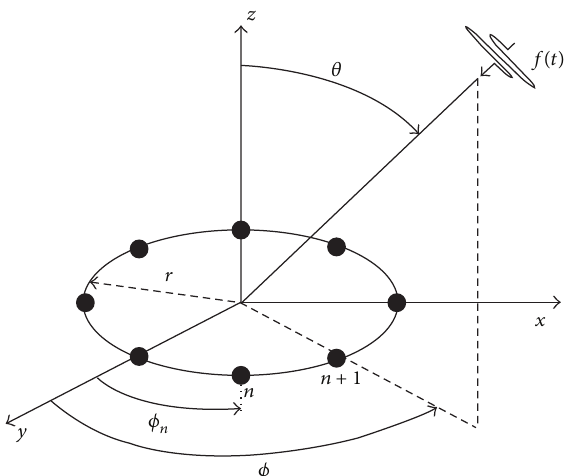
Figure 1: Time-domain circular antenna array